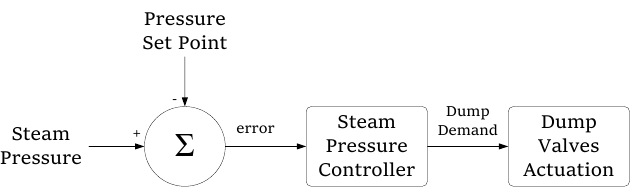
Fig. 1. Steam pressure control mode of steam dump